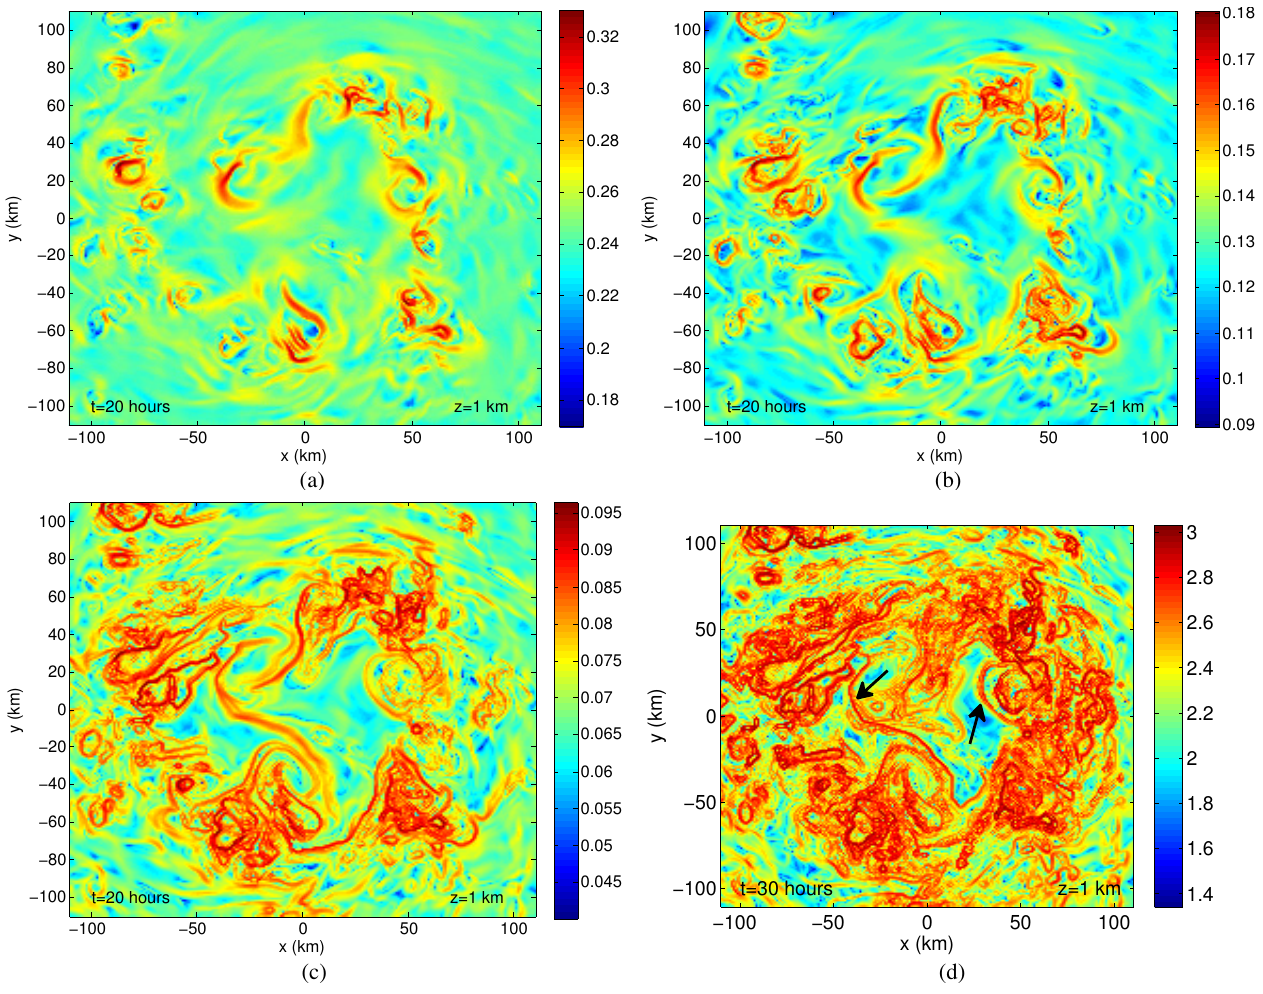
Fig. 4. LCSs from the planar FTLE field are shown for integration times of 30 min (a), 1 h (b), 2 h(c), and 4 h (d). Arrows show examples of LCSs that are visible under all shown integration times.